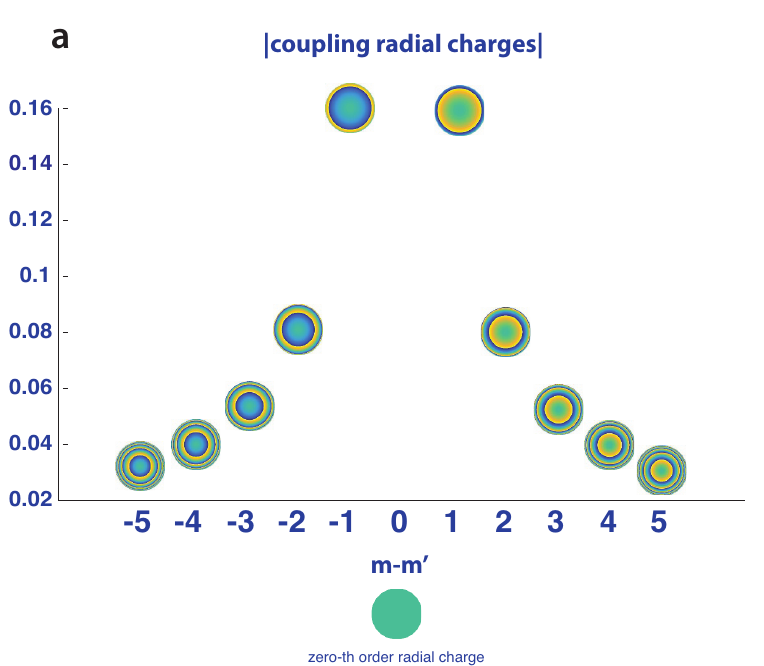
Figure 1. Panel a : Absolute value of the coupling function f ( m , m (cid:48) ) = 1 / [2 i π ( m − m (cid:48) )] + 1 / [2 π 2 ( m − m (cid:48) ) 2 ] among neighbouring radial modes. The curve refers to the coupling of the 0-th order radial charge (shown close to the origin of the x-axis in the graph) with the neighbouring radial charges, of order m ∈ [ − 5 , 5]. On the x-axis the order of each charge is reported, while the phase profile of each charge is used as marker on the curve. Only radial charges corresponding to HNMs of same azimuthal charge n can couple to each